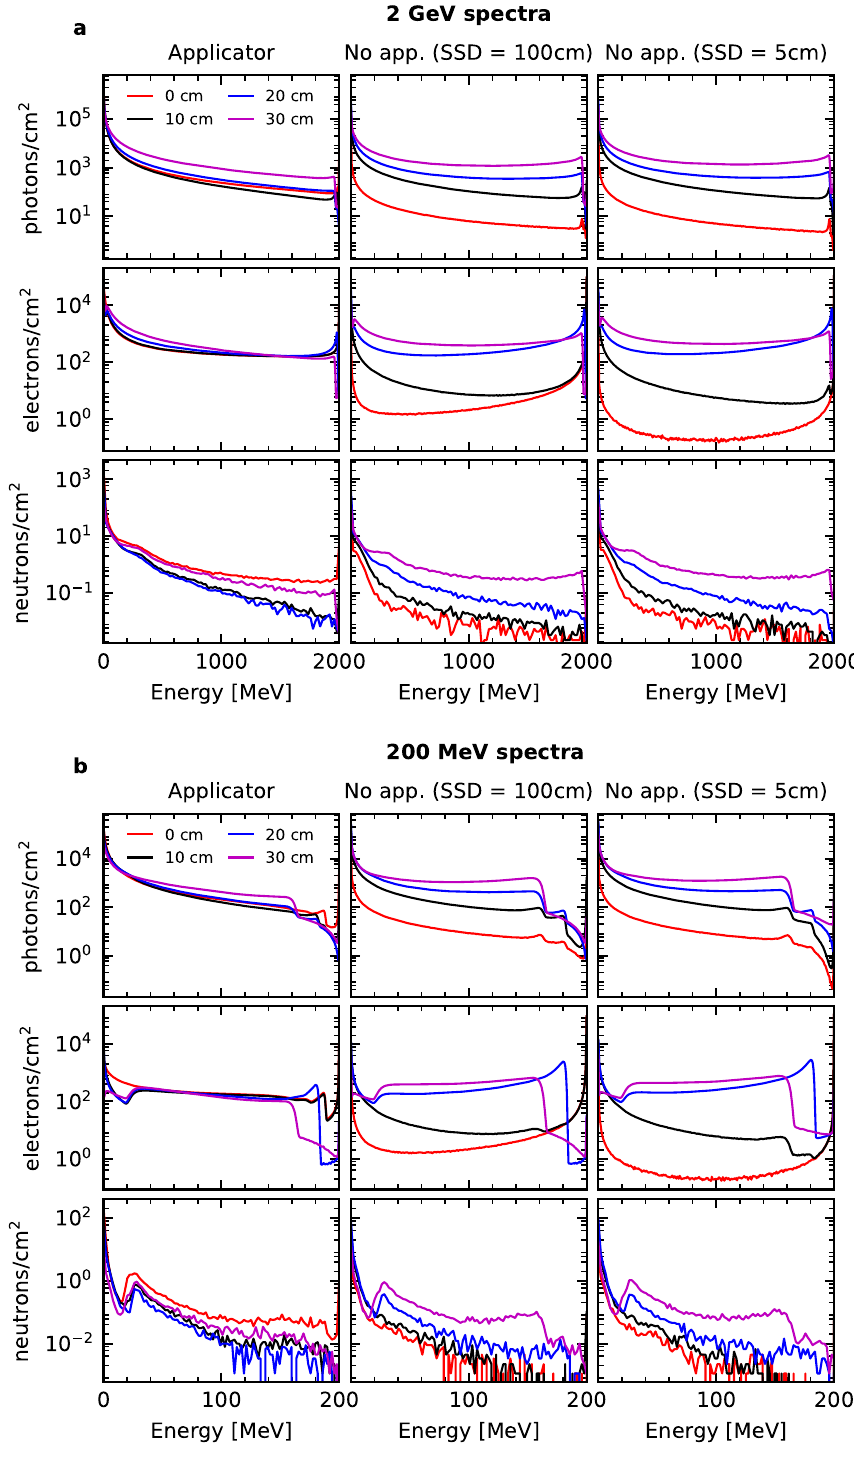
Figure 4. Particle fluences at 0, 10, 20, and 30 cm depth (red, black, blue, and purple curves respectively) in the water phantom for the (a) 2 GeV and (b) 200 MeV electron primaries. Each row: fluence for each particle (photons, electrons, and neutrons) in particles/cm 2 . Each column: the corresponding simulation